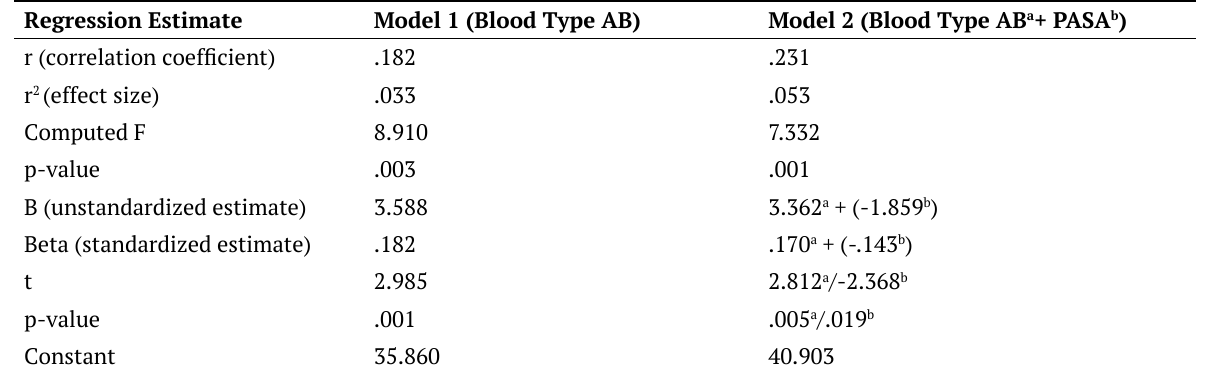
Table 9. Regression estimation procedures of the factors towards participants’ accuracy Regression Estimate